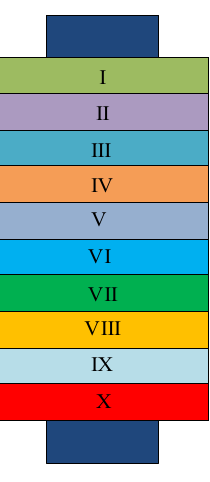
Figure 17. Diagram of winding division. Figure 17 uniformly divides the primary windings of the transformer model into ten intervals, and selects suitable measurement points in each interval, and simulates and analyzes the radial force F r and axial force F a on the primary windings at the measurement points under the inrush current shock.